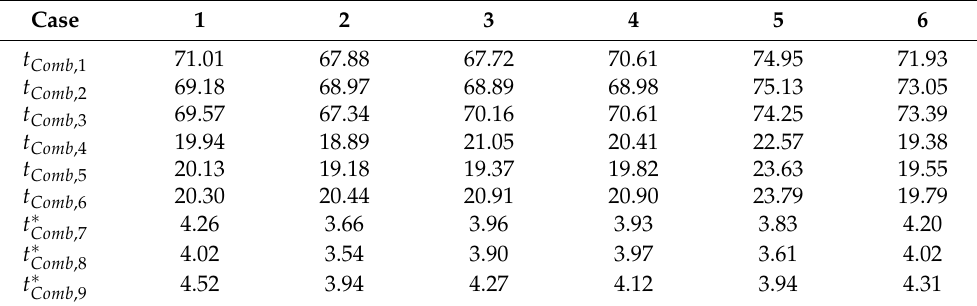
Table 8. Computational time demanded in minutes to run each simulation for the nine combinations and the six